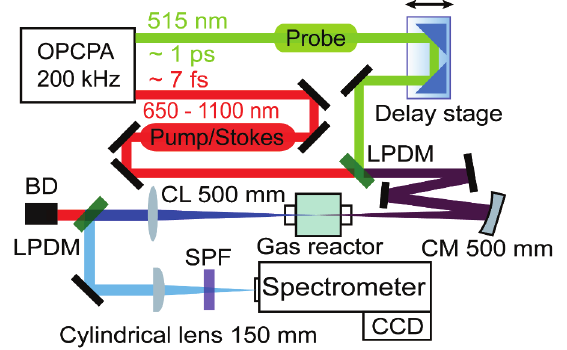
Fig. 1. Fs-CARS experimental setup. LPDM: long pass dichroic mirror; CM: concave mirror; CL: collimating lens; SPF: short pass filter.